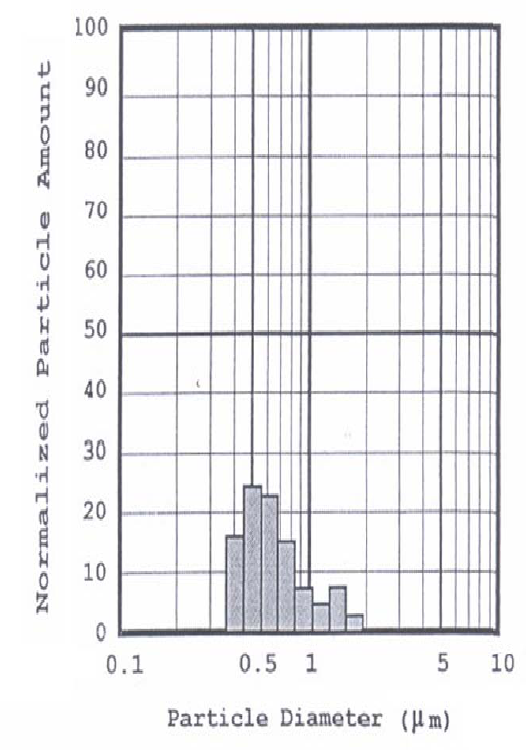
Fig. 3: Particle size distribution of cockles shells powder showing the size species after processing of scrushed shells by ball